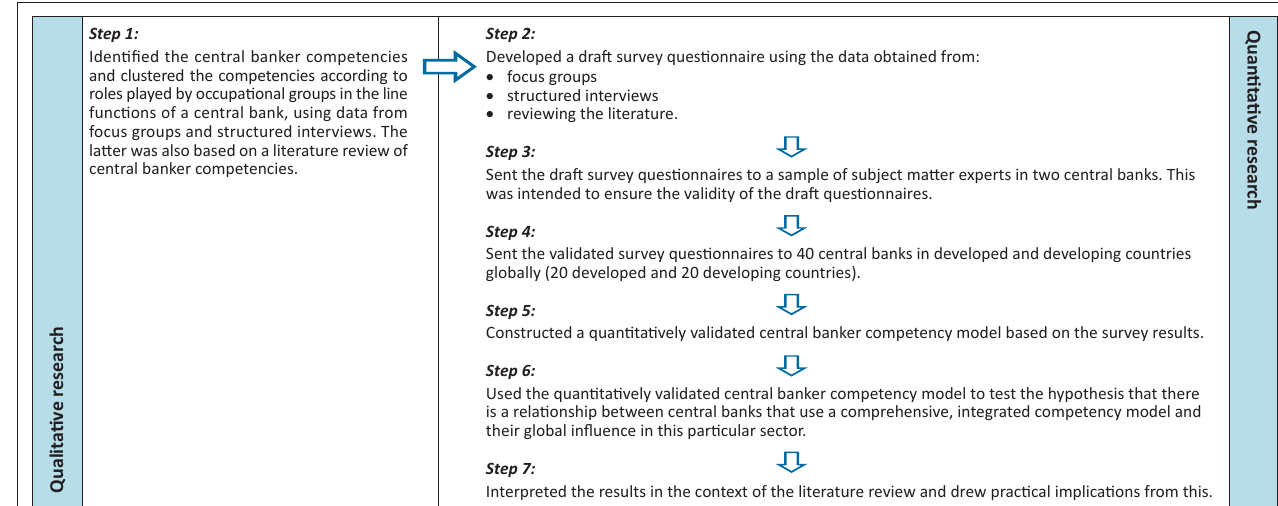
FIGURE 3: Research process employed.